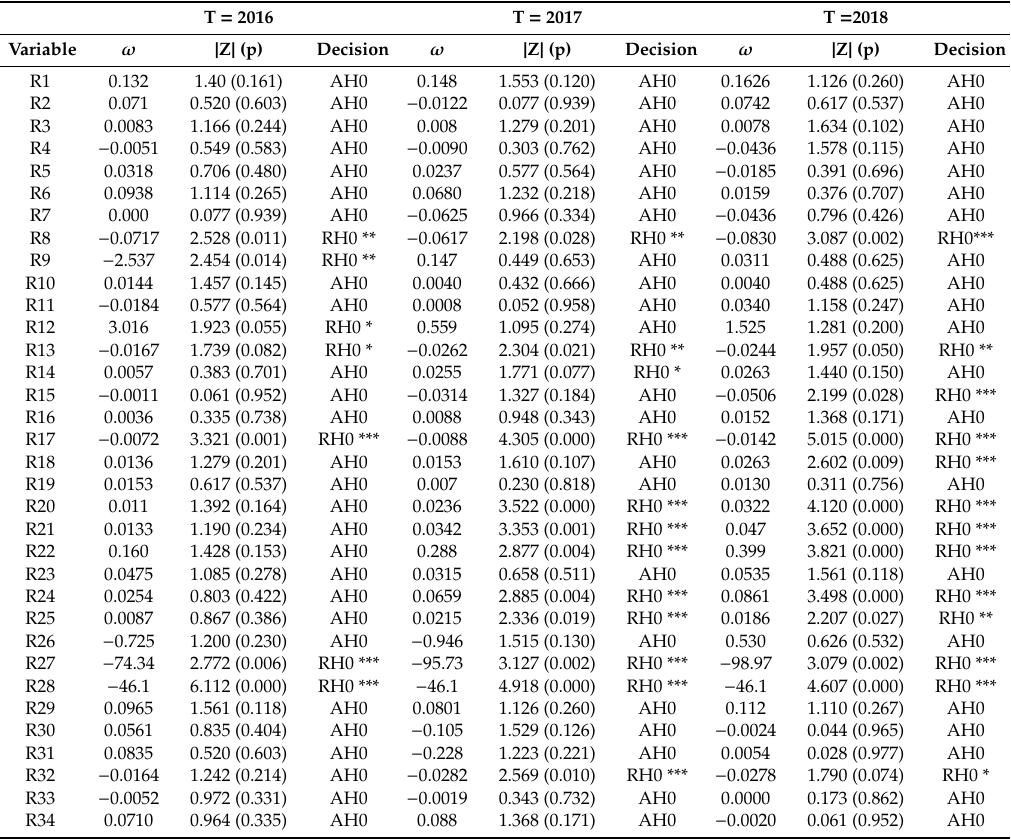
Table 2. Wilcoxon–Mann–Whitney